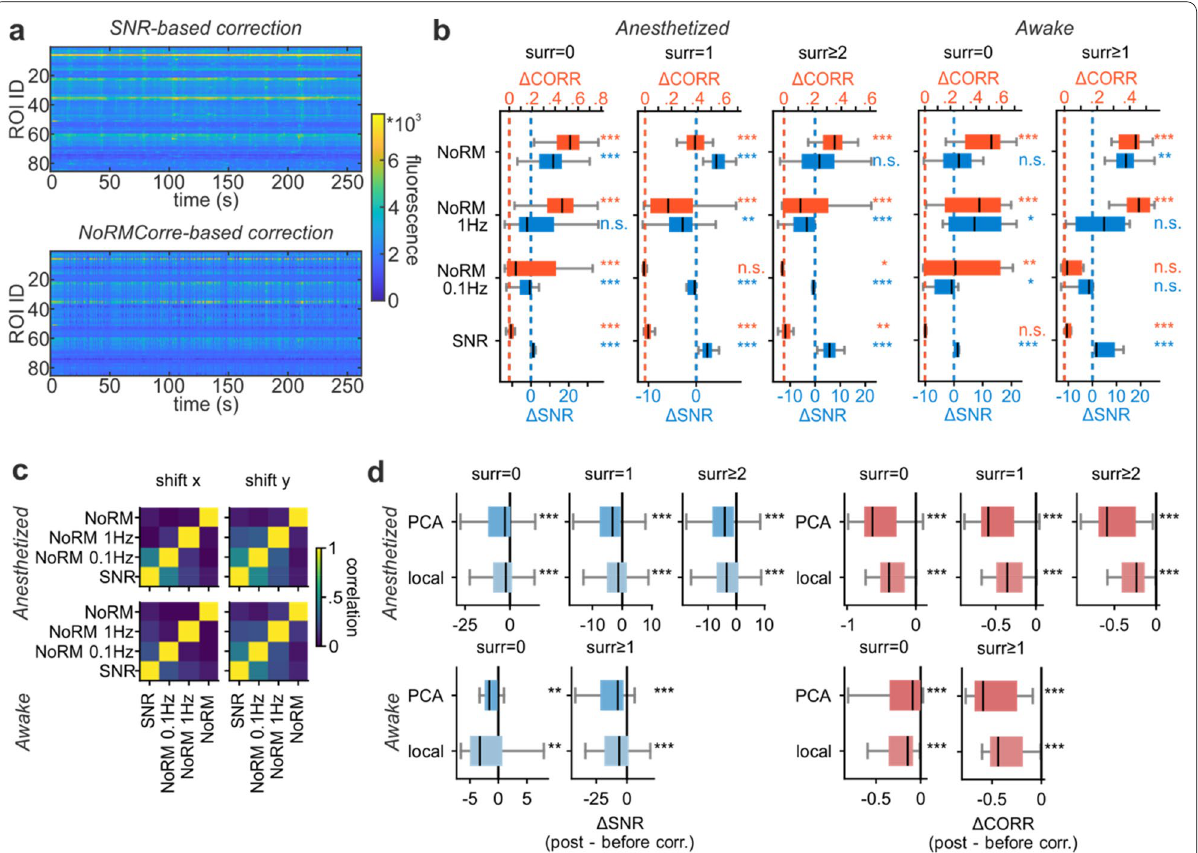
Fig. 5 Small and local artefacts correction and neuropil decontamination. a Fluorescence activity of the same ROIs of Fig. 2a after the correction of artefacts obtained through the reassignment of those pixels that maximize the SNR (top) or through the correction strategy that uses the displacements estimated using the NoRMCorre algorithm [44] on the reference box with a smoothing window of 10 s (bottom). b Effects of different artefacts corrections strategies on the SNR and pairwise correlation of fluorescence traces for different surrounds and animal states. Extended values in Table 4. c Correlations between the displacement along the x -axis (left) or y -axis (right) estimated using different strategies in anesthetized (top) and awake (bottom) animals. d Effects of neuropil decontamination strategies on the SNR and pairwise correlation of fluorescence traces for different surrounds and animal states. Extended values in Table